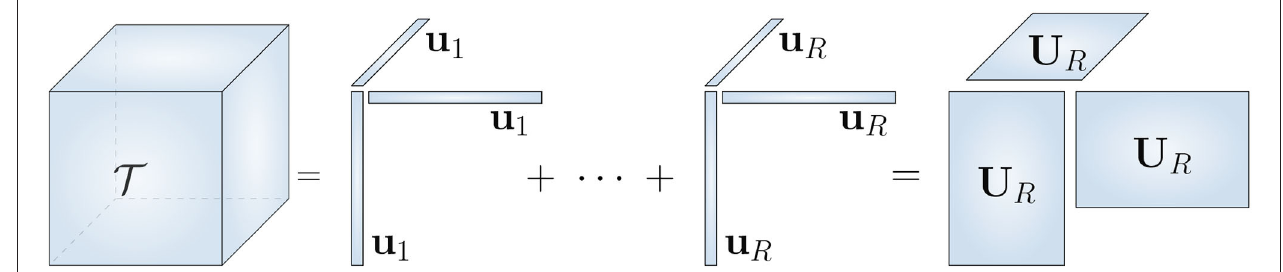
FIGURE 1 | Polyadic decomposition of a third order symmetric tensor T . It is called canonical (CPD) if R is equal to the rank of T , i.e., R is minimal. It allows compact representation of polynomials.